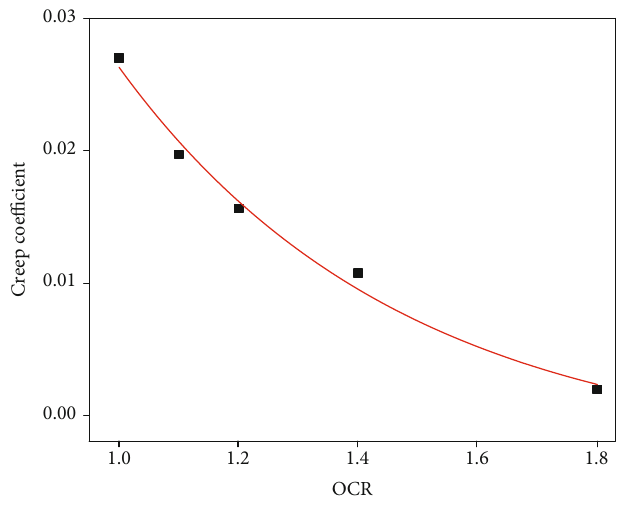
Figure 6: Creep coe ffi cient and